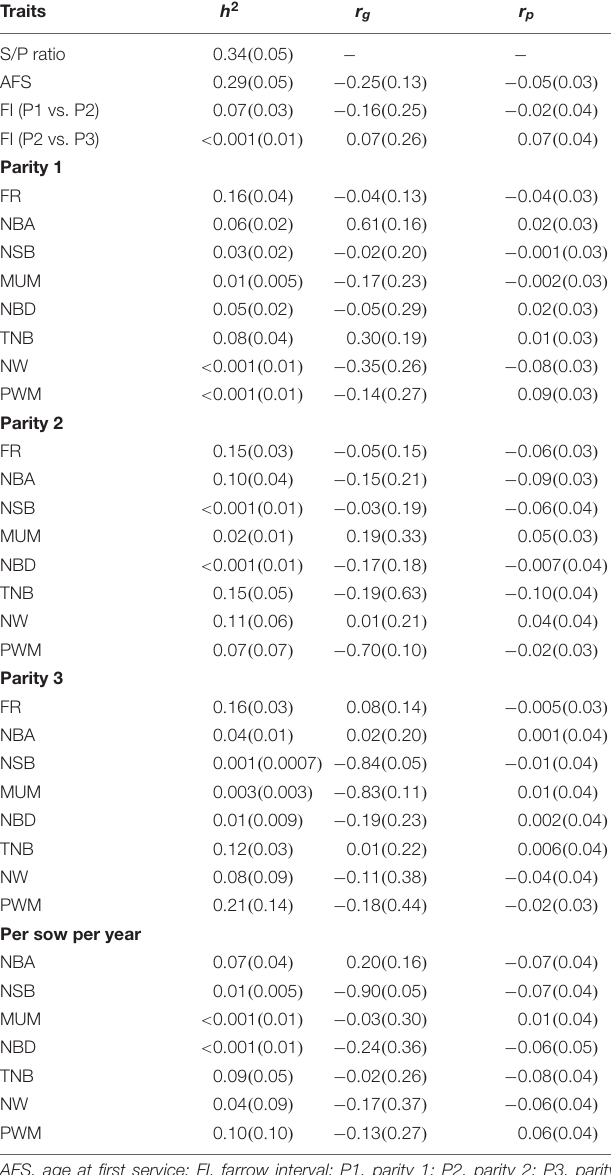
TABLE 2 | Estimates of heritability ( h 2 ) and correlations (genetic and phenotypic; r g and r p , respectively) between antibody response [sample-to-positive (S/P) ratio] to porcine reproductive and respiratory syndrome virus vaccination and reproductive